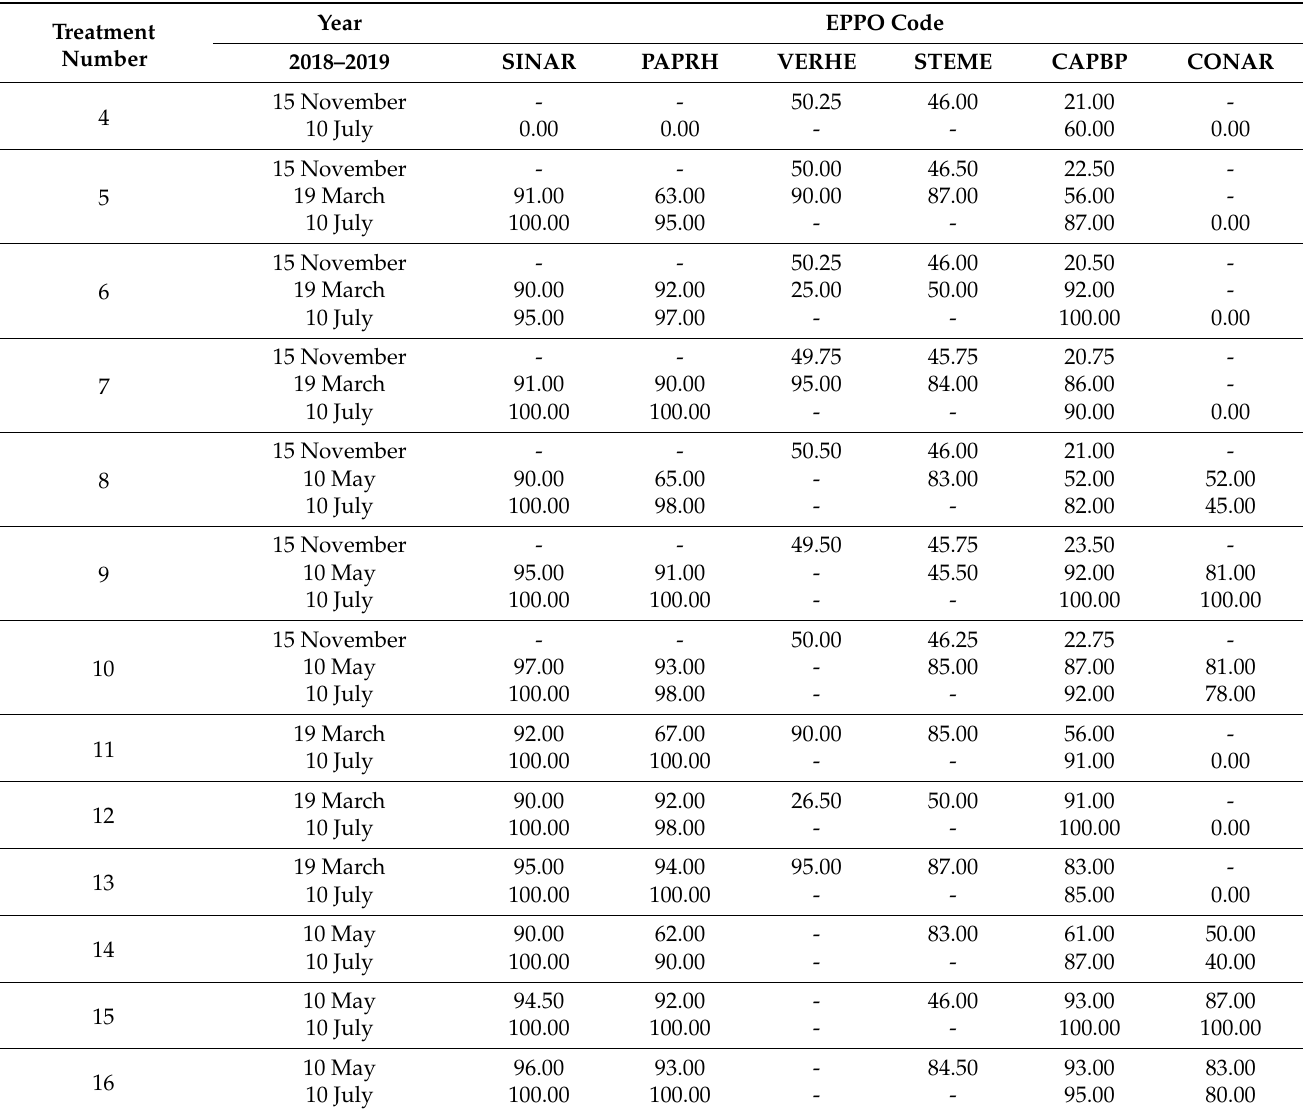
Table 7. Weed control efficiency of chemical treatments compared to weed cover of untreated